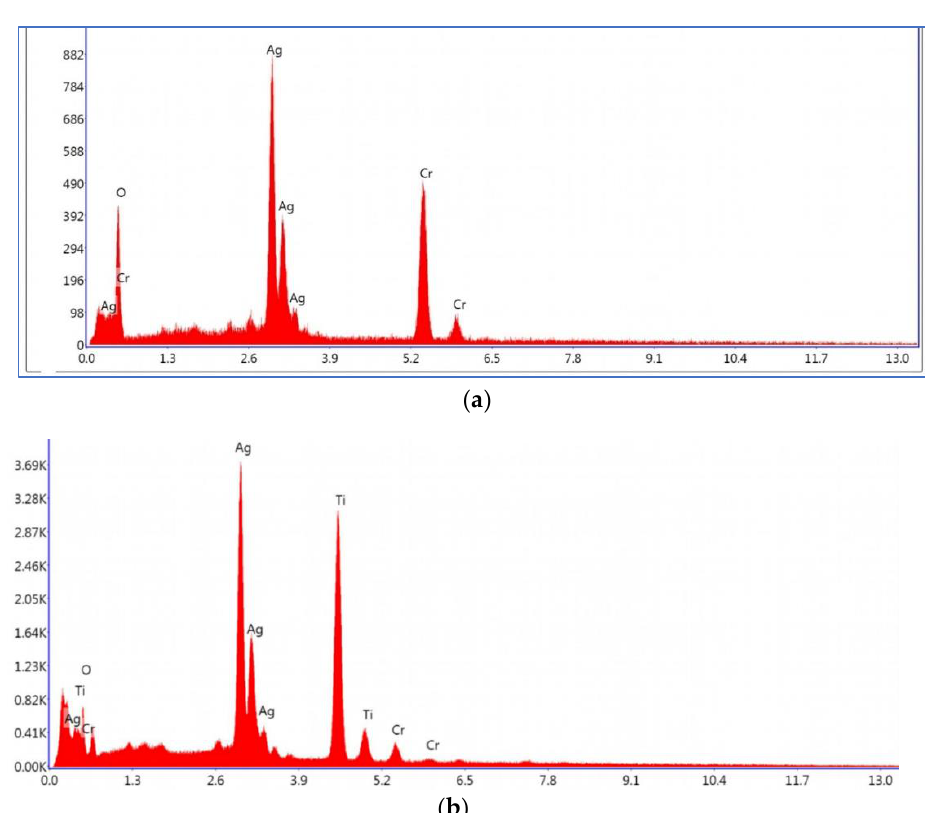
Figure 4. Energy dispersive spectra of ( a ) Ag 2 CrO 4 nanoparticles ( b ) MXene/Ag 2 CrO 4 nanocomposite. Table 1. Estimated elemental composition of MXene/Ag 2 CrO 4 nanocomposite.